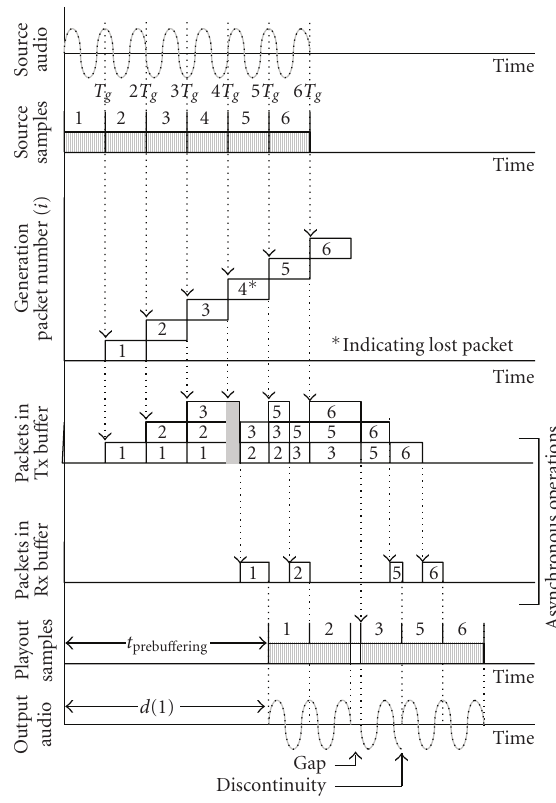
Figure 4: Example of timing analysis in packet-oriented digital audio WLAN